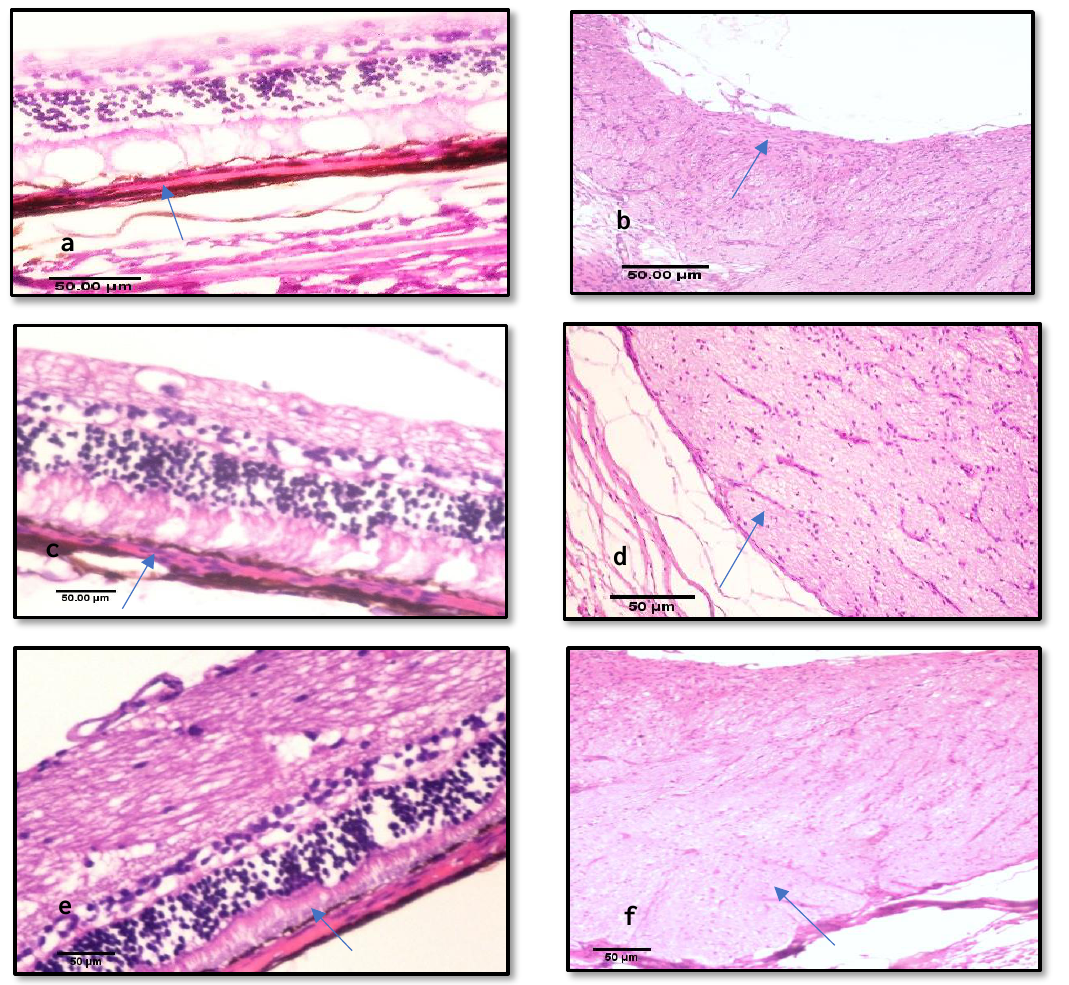
Figure 5. Histopathology microscopy of ( a ) Retinal atrophy with loss of retinal ganglion cells of sham group. ( b ) Optic nerve of sham group showing Wallerian degeneration and marked excavation. ( c ) Mild retinal atrophy with some loss of ganglion cells and small vacuoles after treatment with carvedilol solution (GP1). ( d ) Optic nerve showing Wallerian degeneration and without excavation after treatment with carvedilol solution (GP1). ( e ) Improvement of retinal atrophy with some loss ganglion cells and no vacuolation of choroid after treatment with carvedilol leciplex (GP2). ( f ) Optic nerve showing mild edema and thickening without excavation after treatment with carvedilol leciplex (GP2).